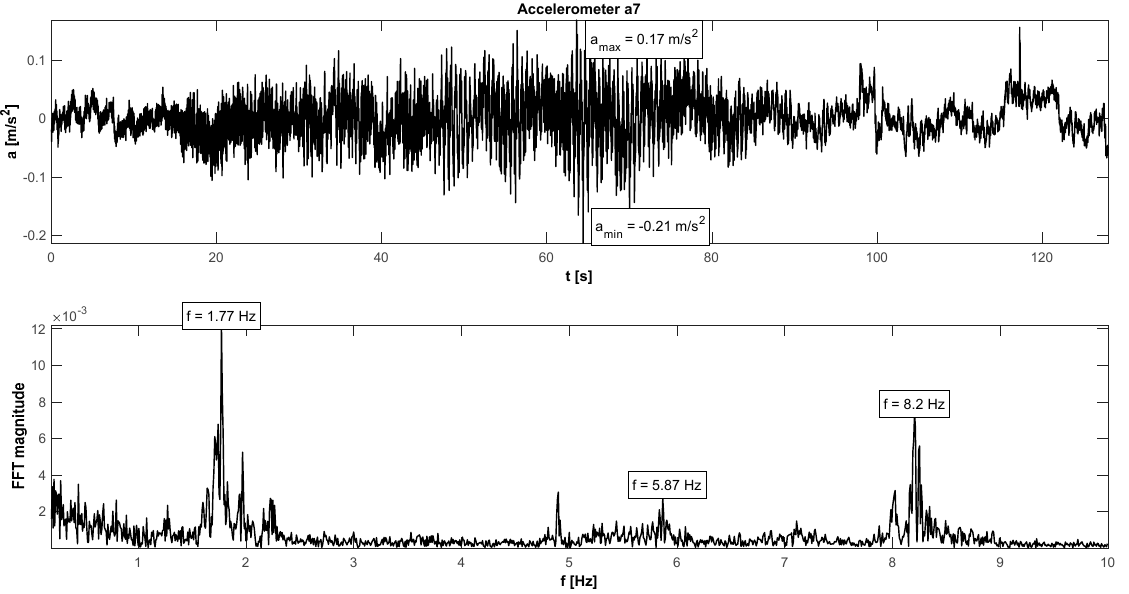
Figure 15. Signal of vertical vibrations in the time and frequency domain registered for 12 people walking.